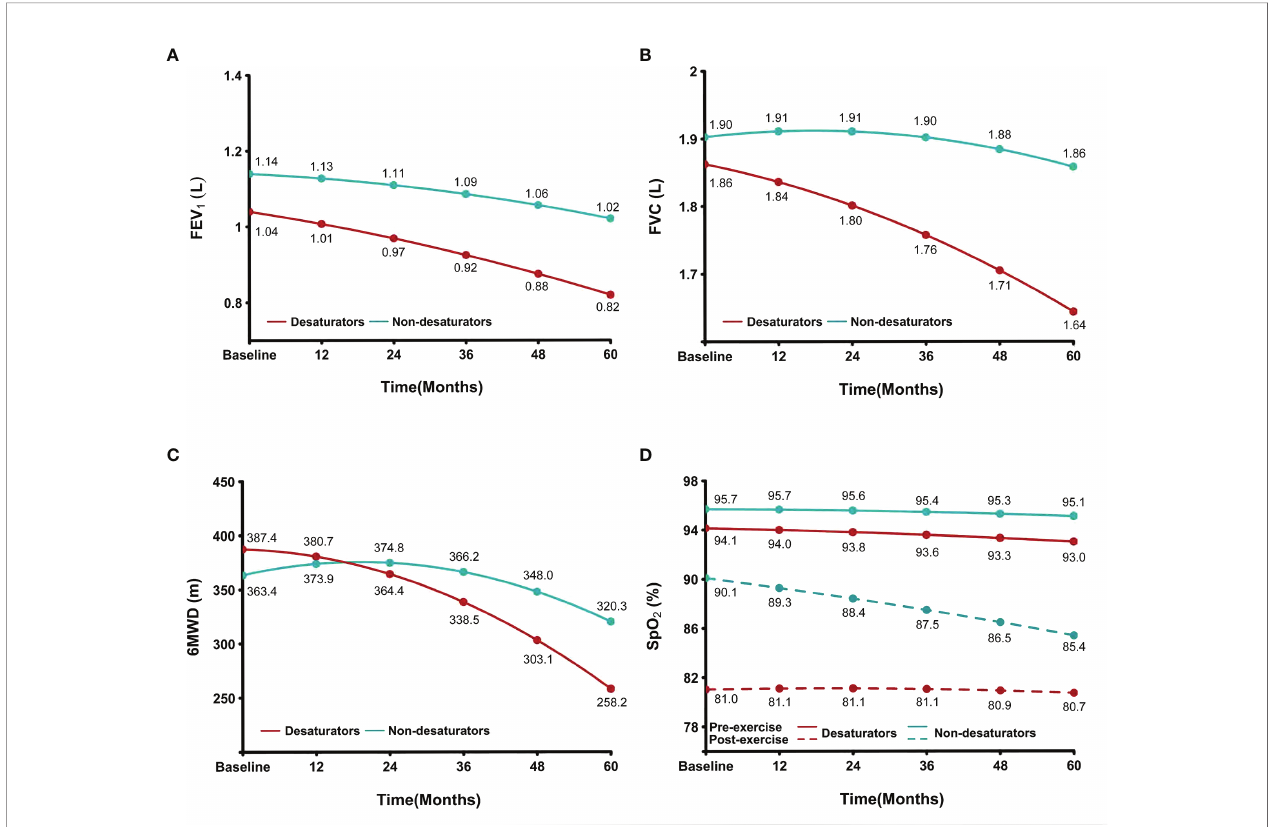
FIGURE 2 | Accelerated reduction in oxygenation, lung function and exercise tolerance in COPD patients with exercise-induced hypoxemia. The data of (A) FEV 1 , (B) FVC, (C) 6MWD and (D) SpO 2 at the point of baseline, 12, 24, 36, 48 and 60 months between non-desaturators (n = 84) and desaturators (n = 86) were indicated in the image of COPD cohort over a 5-year period. SpO 2 , peripheral blood oxygen saturation; FEV1, forced expiratory volume in 1 second; FVC, forced vital capacity; 6MWD, 6-minute walking distance; COPD, chronic obstructive pulmonary disease; L, liter; m,